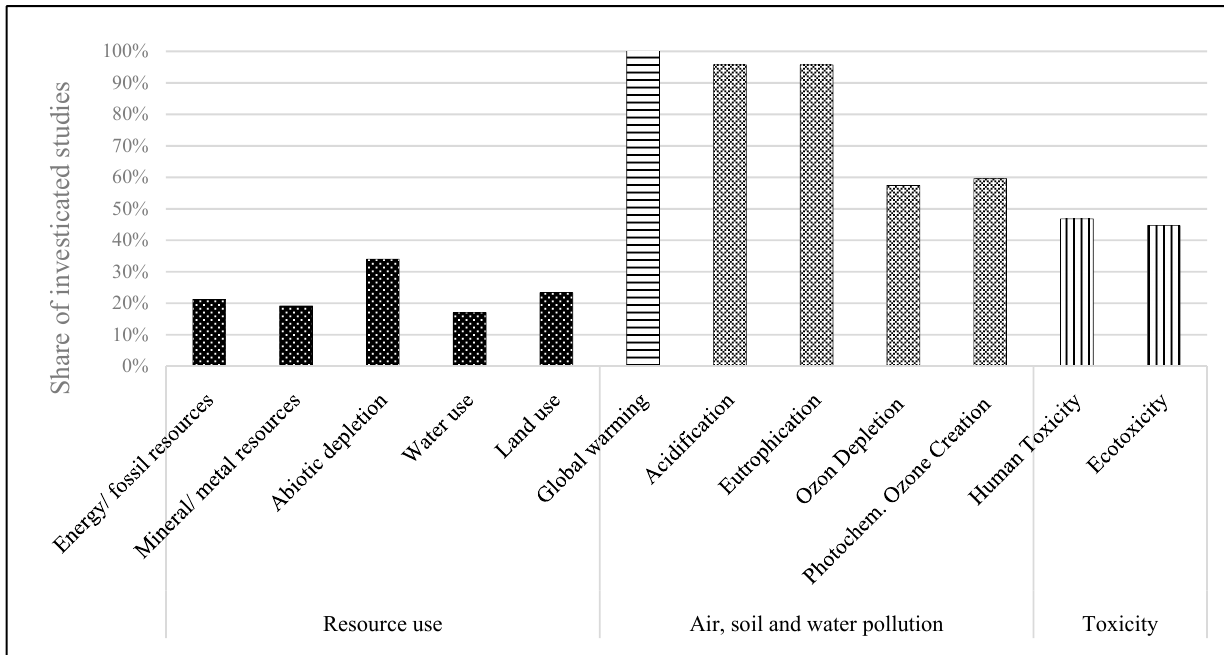
Figure 7. In each impact category, the proportion of studies that use the corresponding impact category is shown to the total number of all studies examined (in %).